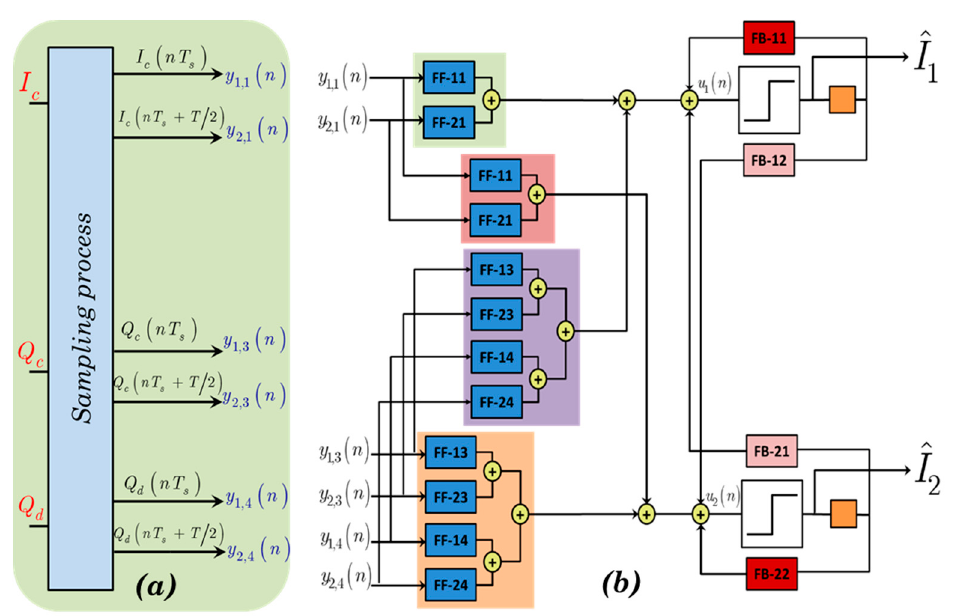
Figure 4. ( a ) Schematic illustration of utilized signals and ( b ) signal flow graph for the proposed partially-joint single-ended DQPSK VDFE[ M f , M b ]- I d .